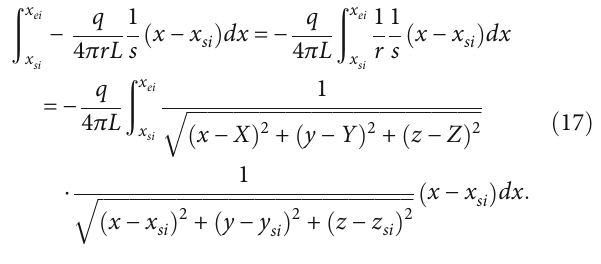
1 ffiffiffiffiffiffiffiffiffiffiffiffiffiffiffiffiffiffiffiffiffiffiffi